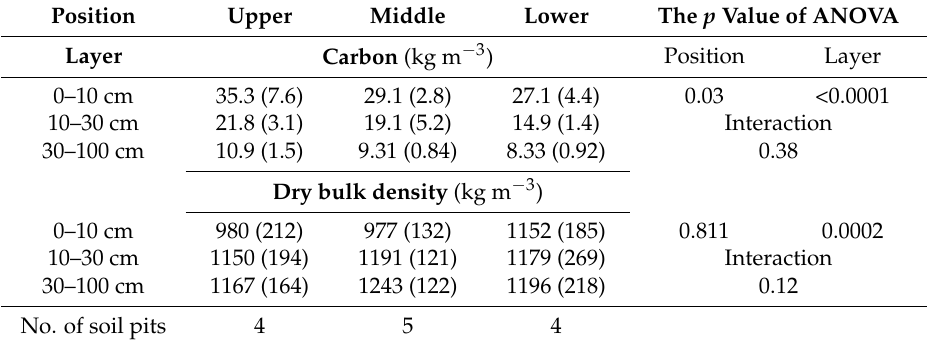
Table 1. Mean density of carbon and dry bulk density in the soil layers at different slope positions. Standard deviations are shown within parentheses. The p values of the two-way analysis of variance (ANOVA) test were calculated for the factors of slope position and soil layer. Position Upper Middle Lower The p Value of ANOVA